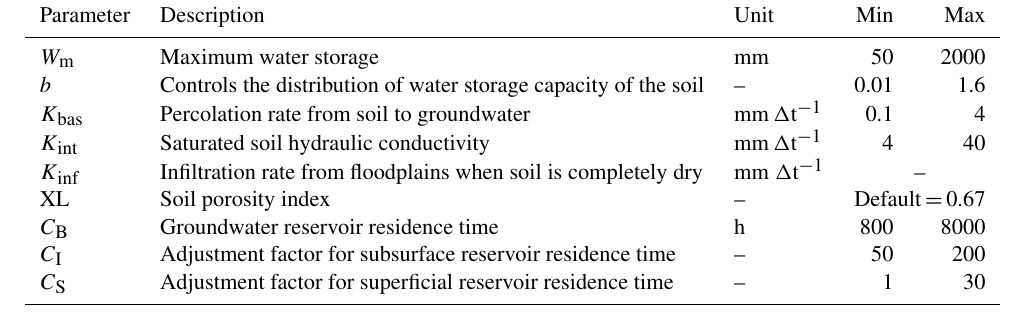
Table 1. Parameters used to calibrate the rainfall-runoff module of MGB, including their respective (typical) range of values.